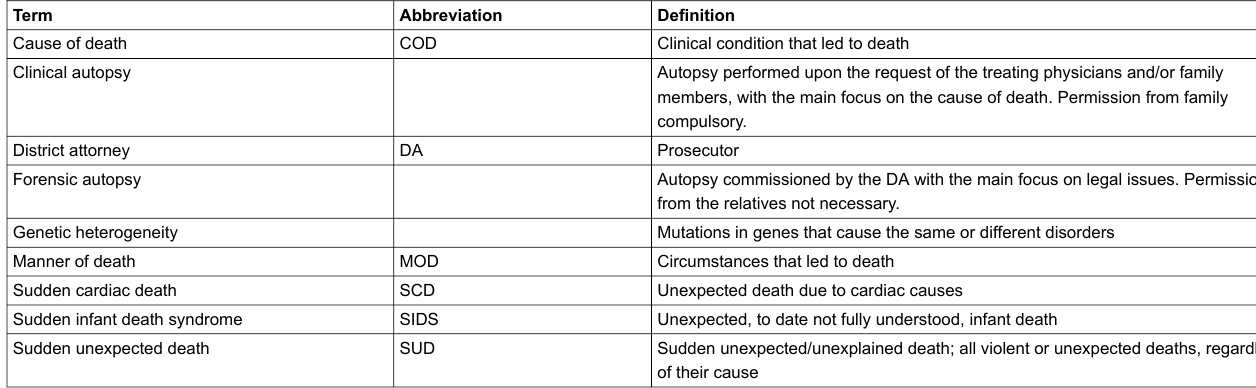
Table 2: Terms, abbreviations and definitions used in Swiss forensic pathology (in alphabetical order).